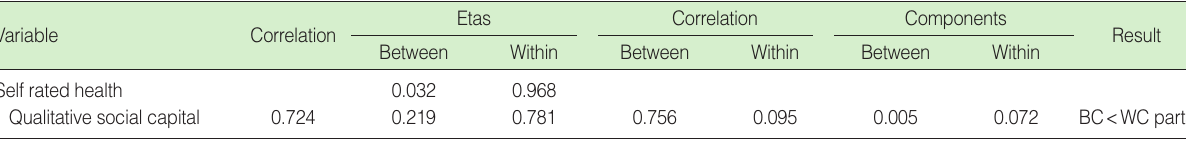
Table 3. Within group and between group variance